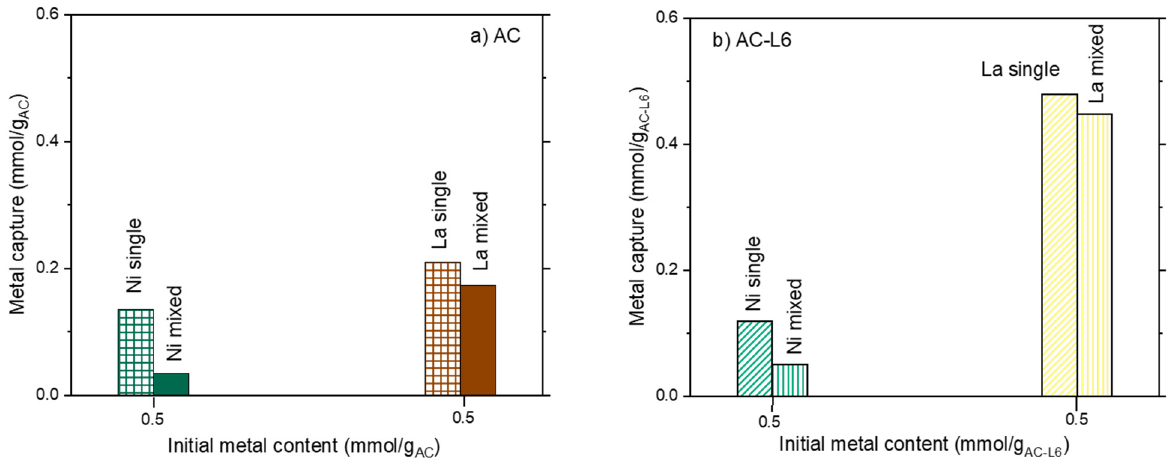
Figure 7. Comparison of the ratio between metal capture and contacted metal in La and Ni single ion and Ni/La mixed solutions for ( a ) unmodified AC and ( b ) modified ACL6.